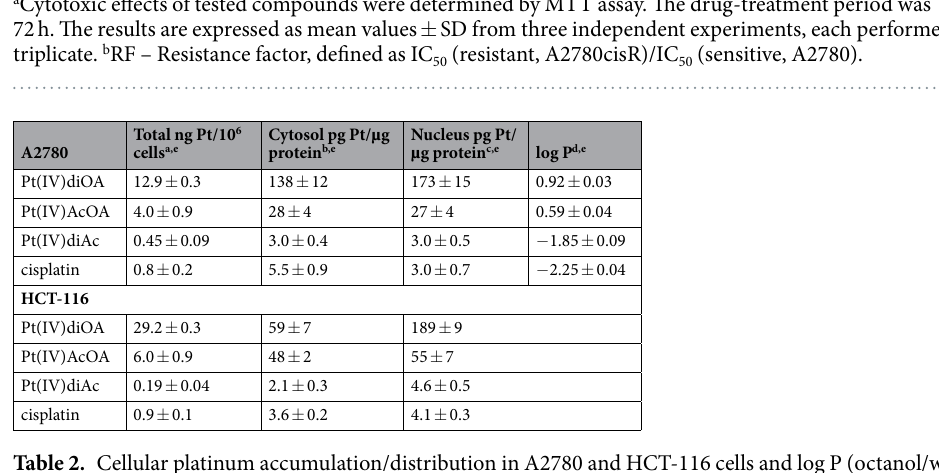
Table 2. Cellular platinum accumulation/distribution in A2780 and HCT-116 cells and log P (octanol/water) values obtained by shake flask method. a The table shows the cellular platinum accumulation into A2780 and HCT-116 cells after 24 h of exposure to 0.35 µ M of the compounds. b,c Platinum accumulation in different pools of A2780 and HCT-116 cells (nucleus b and cytosol c ). d log P values obtained by shake flask method. e Results are expressed as the mean ± SD for three independent experiments with triplicate for each